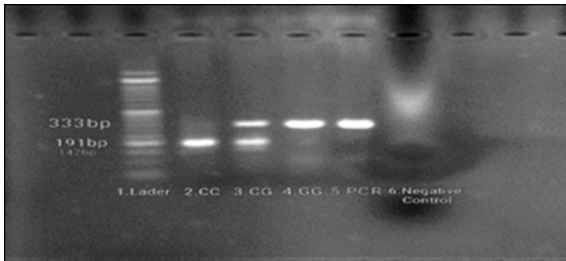
Figure 4. PCR-RFLP Results in Gel Electrophoresis: (1) Ladder, (2) CC, (3) CG, (4) GG, (5) PCR Product, and (6) Negative Control. Note . PCR-RFLP: Polymerase chain reaction-restriction fragment length